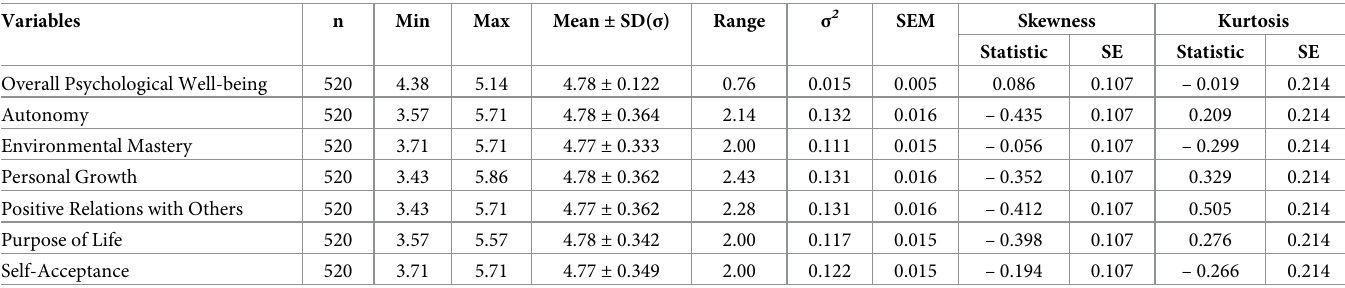
Table 5. Descriptive statistics of seondary school teachers’ psychological well-being.